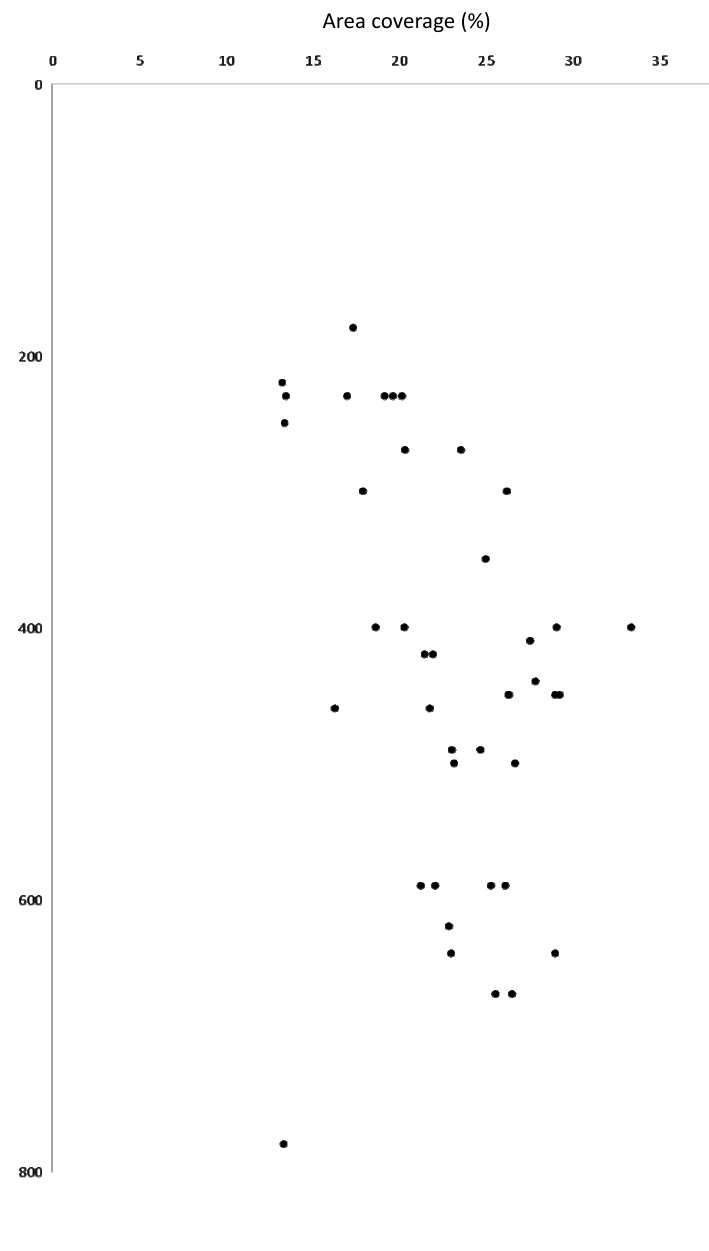
Figure S2. Scatter plot of total biomass areal density fraction vs. depth into the carrier. Each data point corresponds to the percentage coverage of the Eub338 probe mix, as determined by FISH, of the community in an assembled “wall-to-wall” micrograph from the indicated depth in the mature